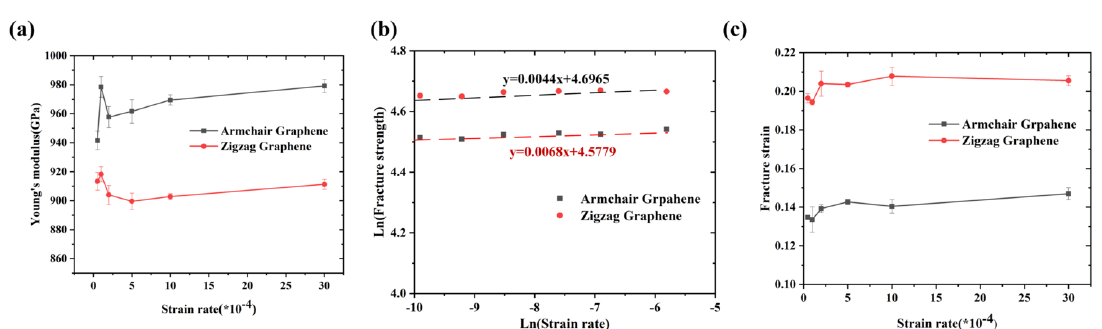
Figure 8. ( a ) The Young’s modulus; ( b ) the fracture strength; and ( c ) the fracture strain of Gr along the armchair and zigzag directions at different strain rates.